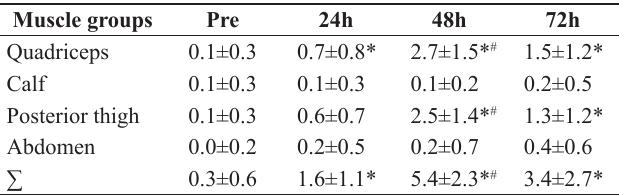
Table 1. DOMS determined pre and 24, 48 and 72h after the training session.